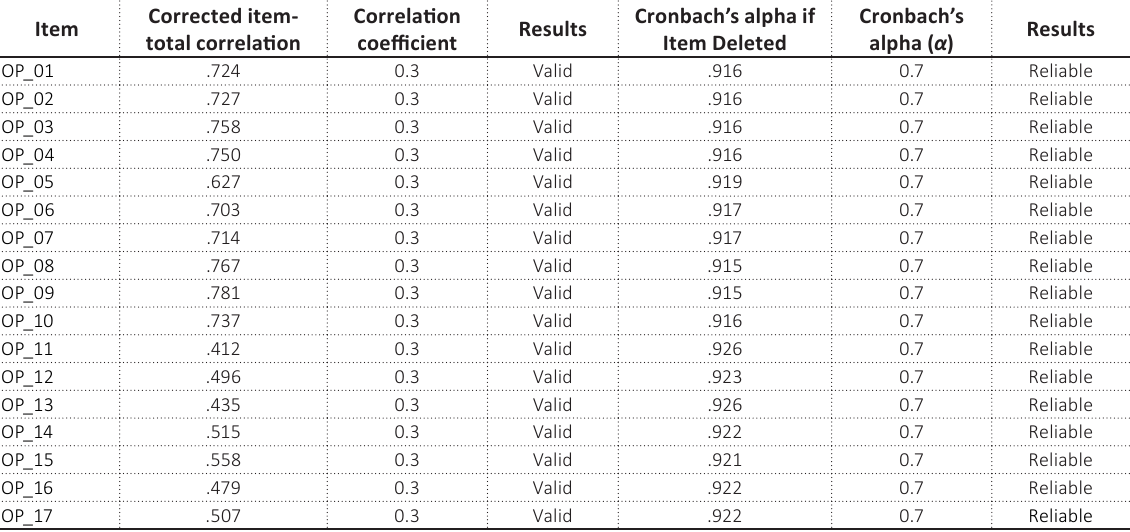
Source: Authors’ elaboration.